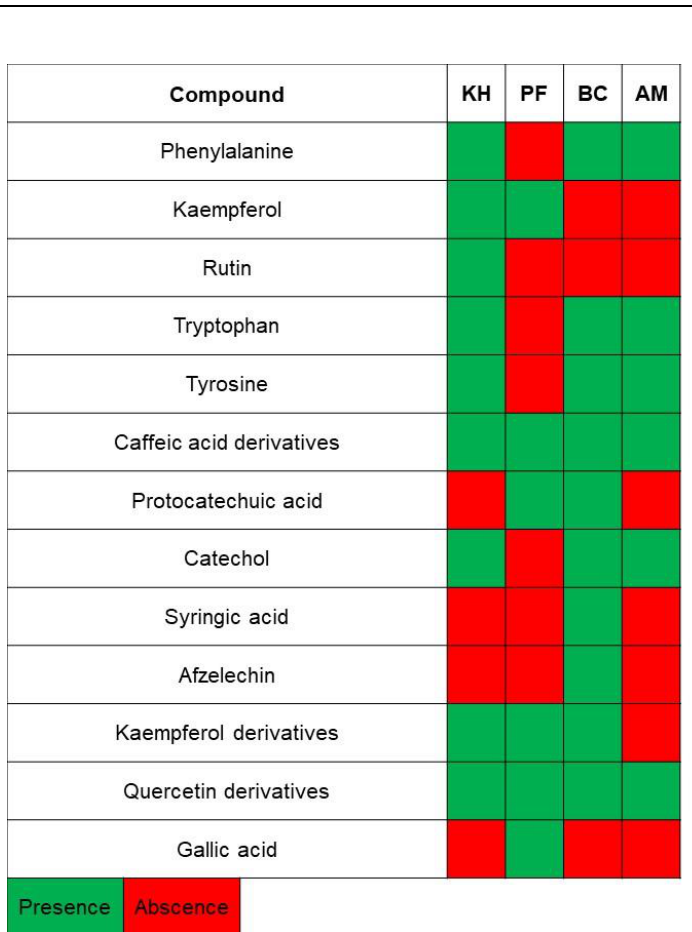
Figure 1. The presence of bioactive compounds in fruit samples. Abbreviations: KH, Actinidia (A.) deliciosa cv. Hayward; BC, A . eriantha cv. Bidan; AM, A . arguta cv. Cheongsan; PF, Diospyros kaki Thunb. cv. Fuyu.